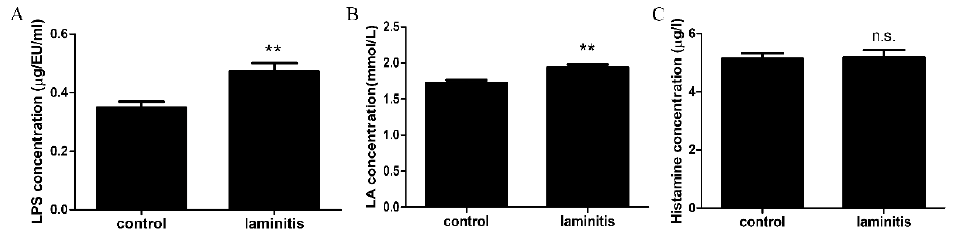
Figure 1. LPS, lactic acid, and histamine in plasma the concentration of ( A ) LPS, ( B ) lactic acid, and ( C ) histamine in plasma between control and laminitis cows. ** p < 0.01 are significantly different from laminitis group. n.s. means there is no significant difference between the two groups.